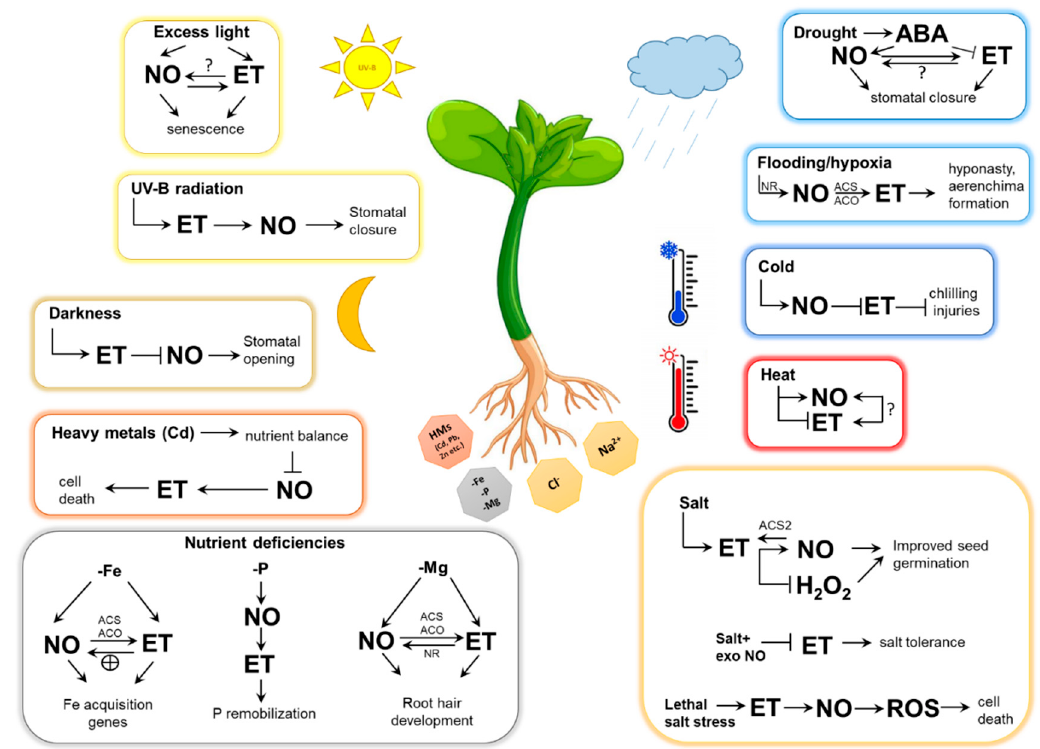
Figure 3. Schematic representation of nitric oxide (NO)-ethylene (ET) interplay during abiotic stress responses in plants. Abbreviations: ABA, abscisic acid; ACS, 1-aminocyclopropane-1-carboxylic acid synthase, ACO, aminocyclopropane-1-carboxylic acid oxidase, NR, nitrate reductase; H 2 O 2 , hydrogen peroxide; ROS, reactive oxygen species; exo NO, exogenous NO; HMs, heavy metals; -Fe, iron deficiency; -P, phosphorus deficiency; -Mg, magnesium deficiency.